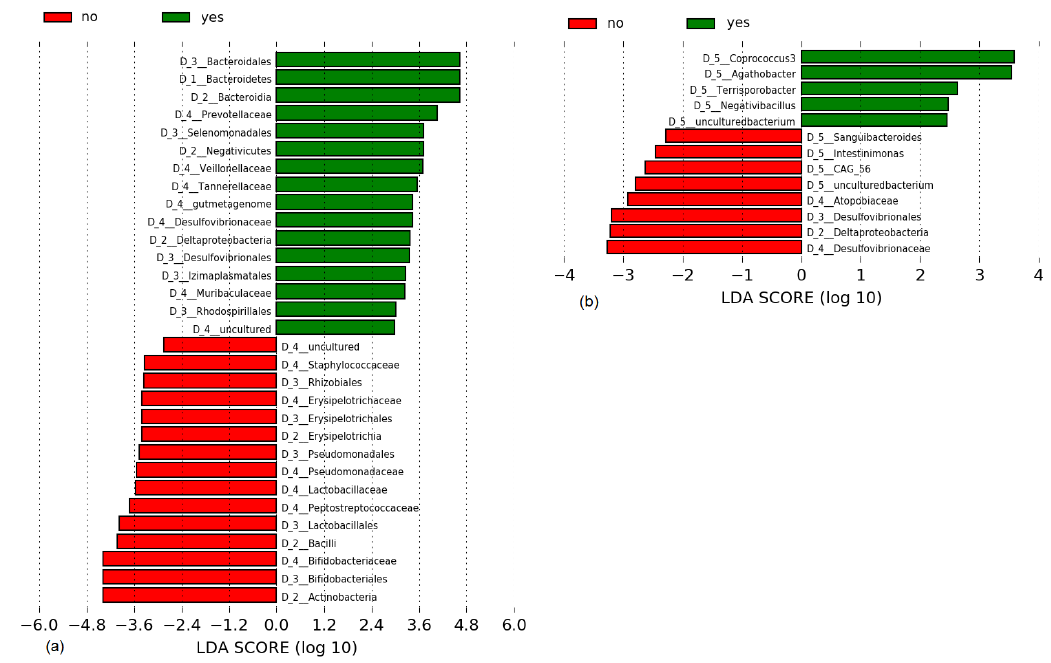
Figure 3. Linear discriminant analysis (LDA) scores of the microbial taxa of responders (yes) and non-responders (no) to ( a ) fecal microbial transplantation and ( b ) 5-aminosalicylic acid treatment of patients with left-sided ulcerative colitis.